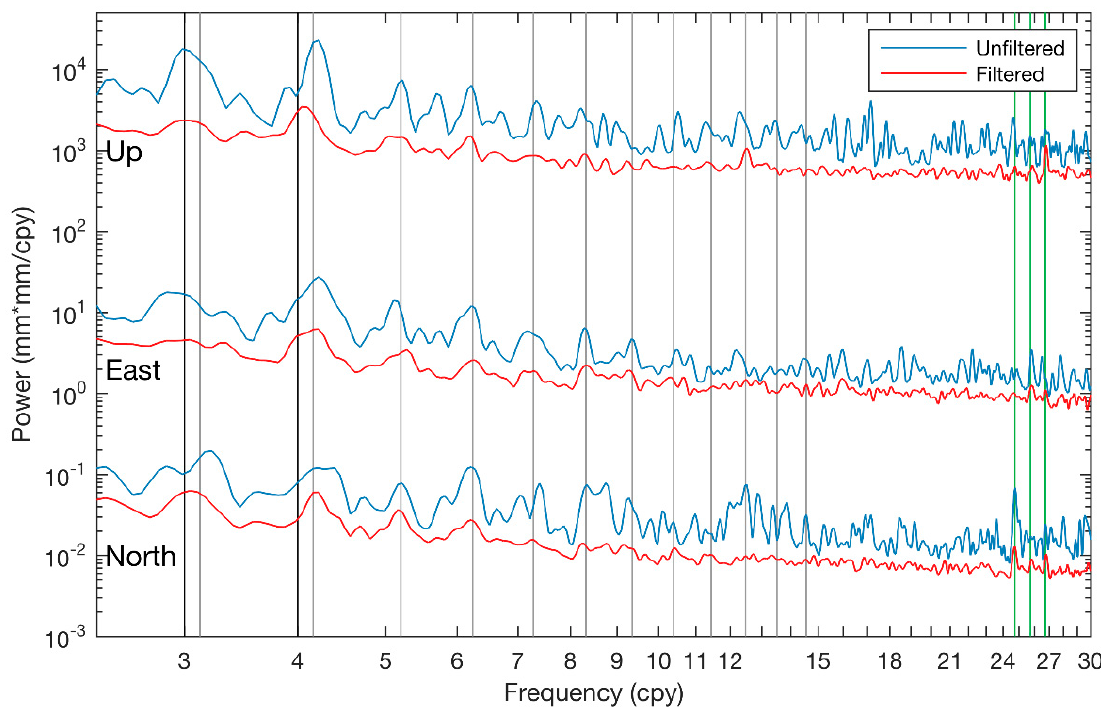
Figure 10. Same as Figure 8, but for the CMONOC-II time series.